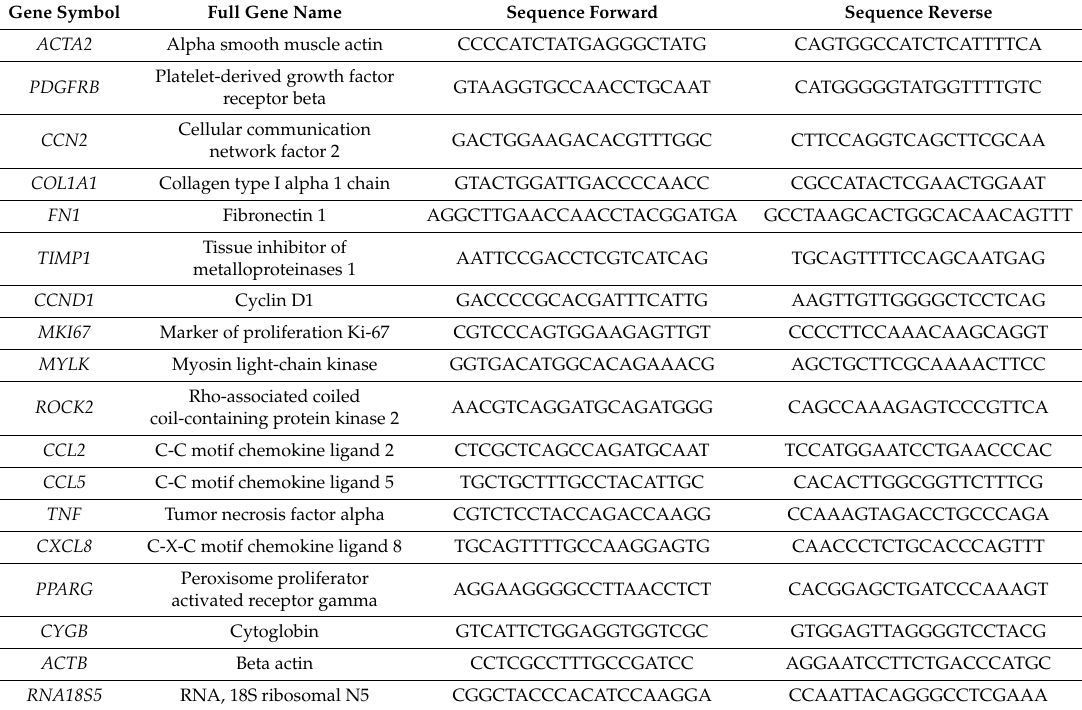
Table 1. Primer sequences used for quantitative real-time